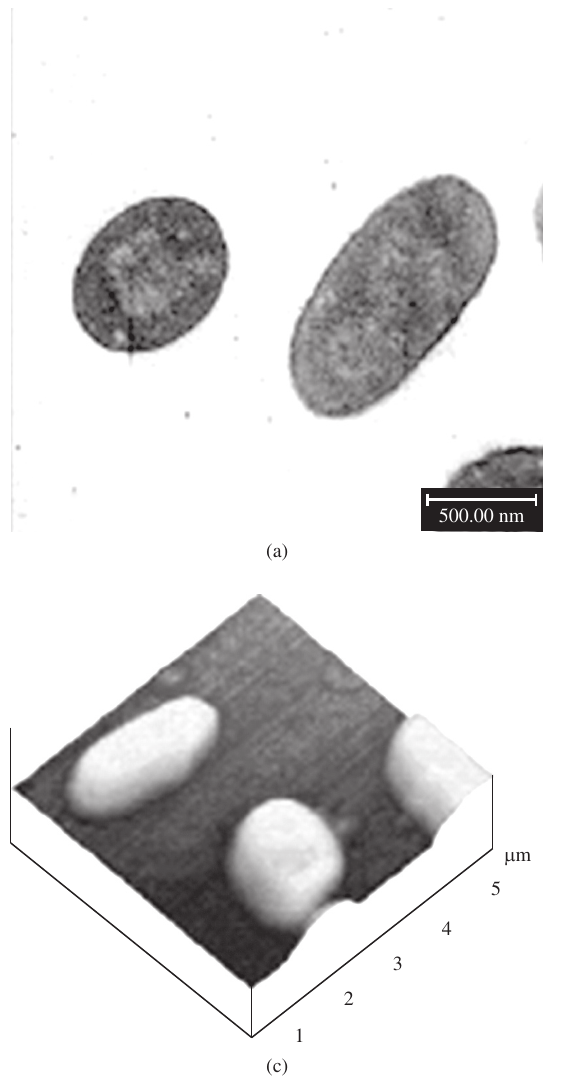
= 10 8 CFU.mL –1 , [KH -PO ] = 0.2 M, 0 2 4 0